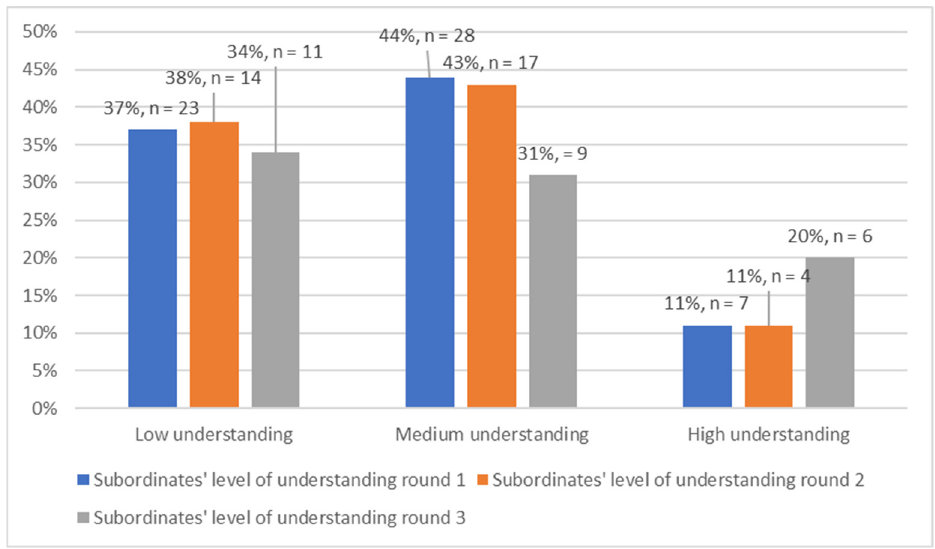
Figure 4. Subordinates’ level of understanding ( n = 135).